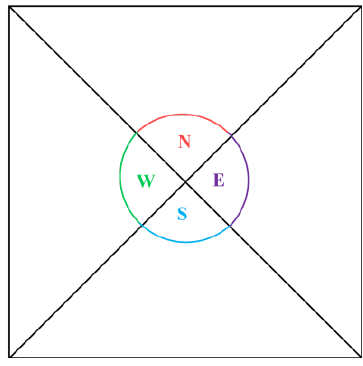
Figure 6. The division of direction. N, E, S, and W, respectively, denote the north, east, south, and west directions of the cargo ship.